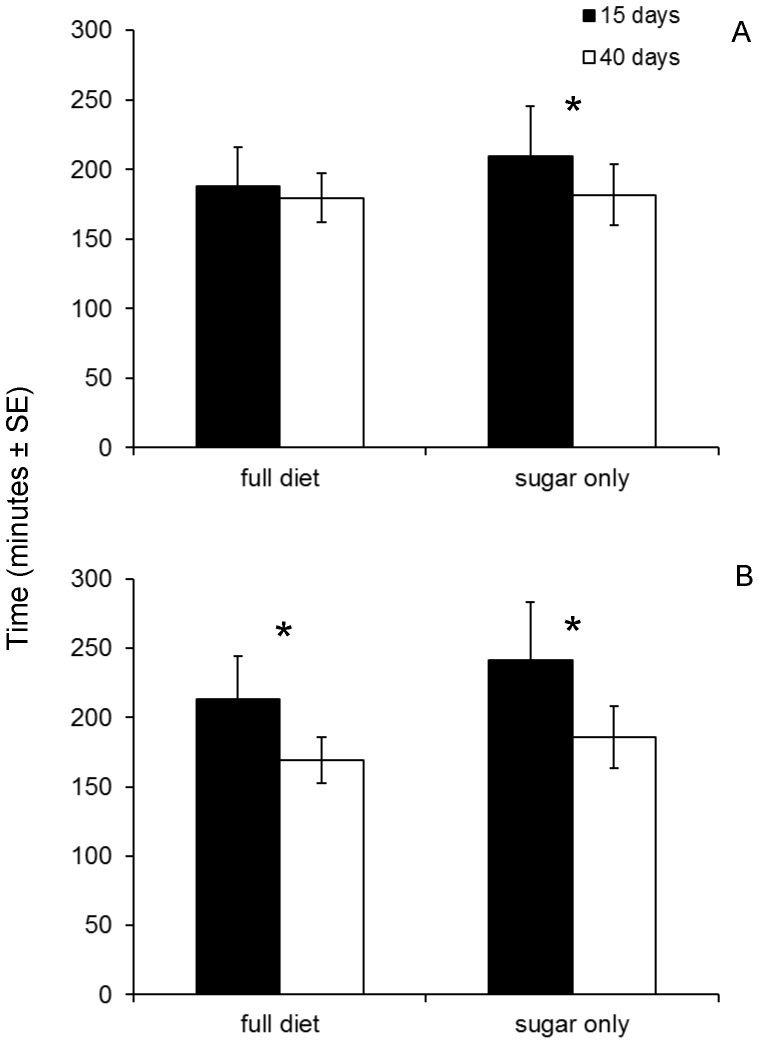
Copulation duration (A) and latency time (B) of females fed a full (left) and a protein-deprived (right) diet.Asterisks (*) indicate significant differences (t-test, P<0.05).